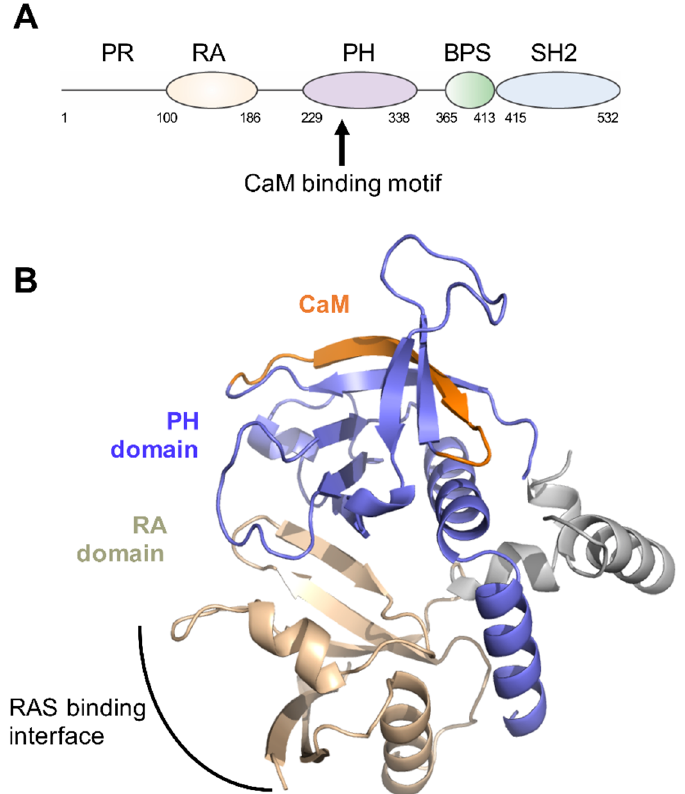
Figure 1. Grb7 domain structure. ( A ) Schematic depicting the arrangement of Grb7 domains and highlighting the position of the postulated calmodulin (CaM) binding site; ( B ) Model of the Grb7 RA-PH domains based upon the Grb10 RA-PH structure (PDB:3HK0). The RA domain is coloured wheat, the PH domain is purple and the residues that correspond to the Grb7 CaM-BD are coloured orange.